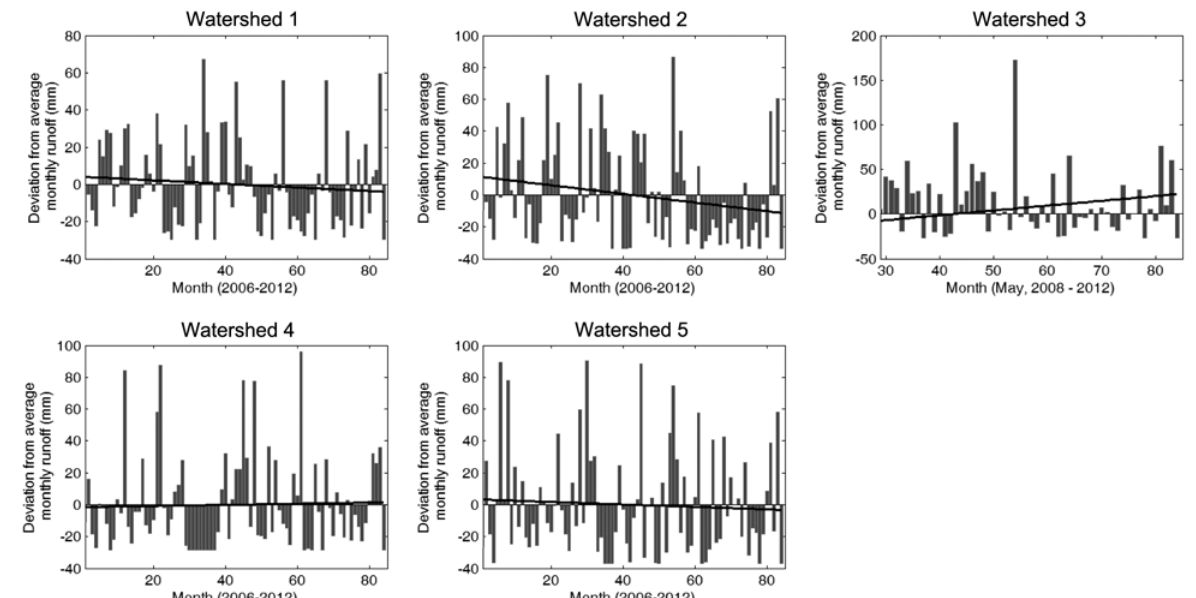
Fig. 6. Monthly deviation from average surface runoff amounts in